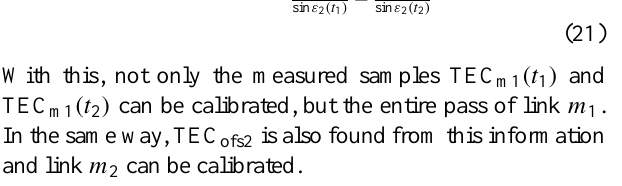
i , and VTEC j (t) = VTEC in the ionosphere at location j as a function of